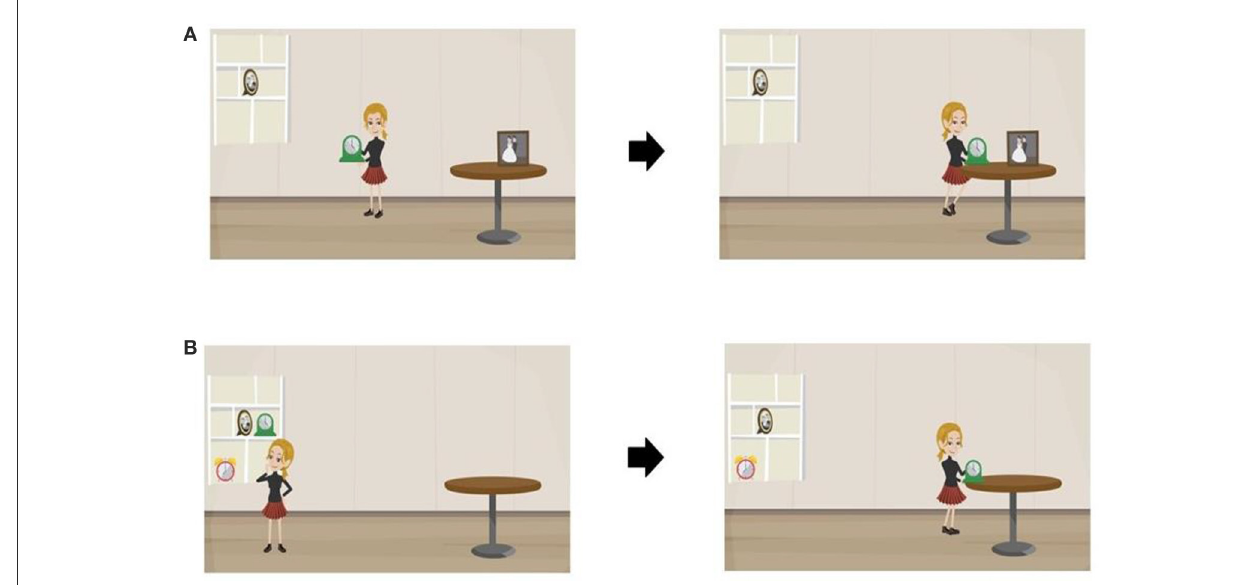
FIGURE1 Parts of the animations representing two different attachment types for the sentence “Ze zet de klok naast de foto op de tafel” (She puts the clock next to the photo on the table): (A) High-Attachment interpretation. (B) Low-Attachment